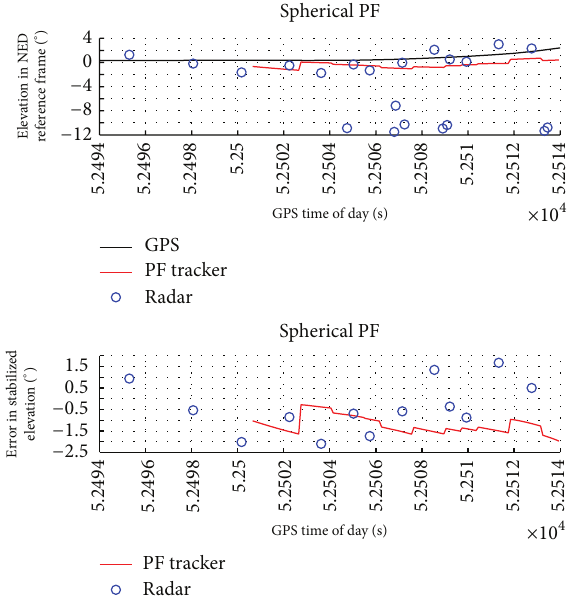
Figure 7: Elevation in NED reference frame as estimated by GPS, by radar, and by radar-only tracker and estimation error as a function of GPS time of day.